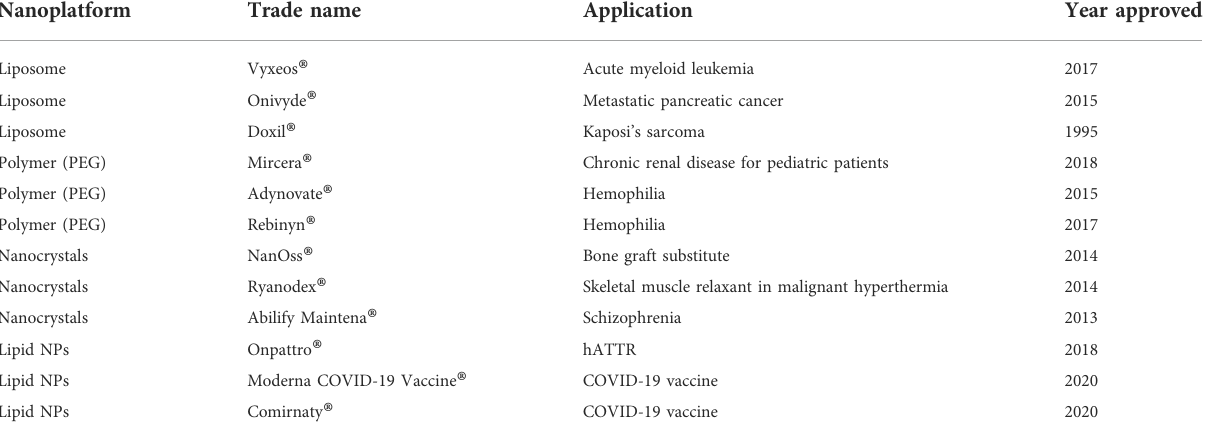
TABLE 1 Examples of FDA-approved